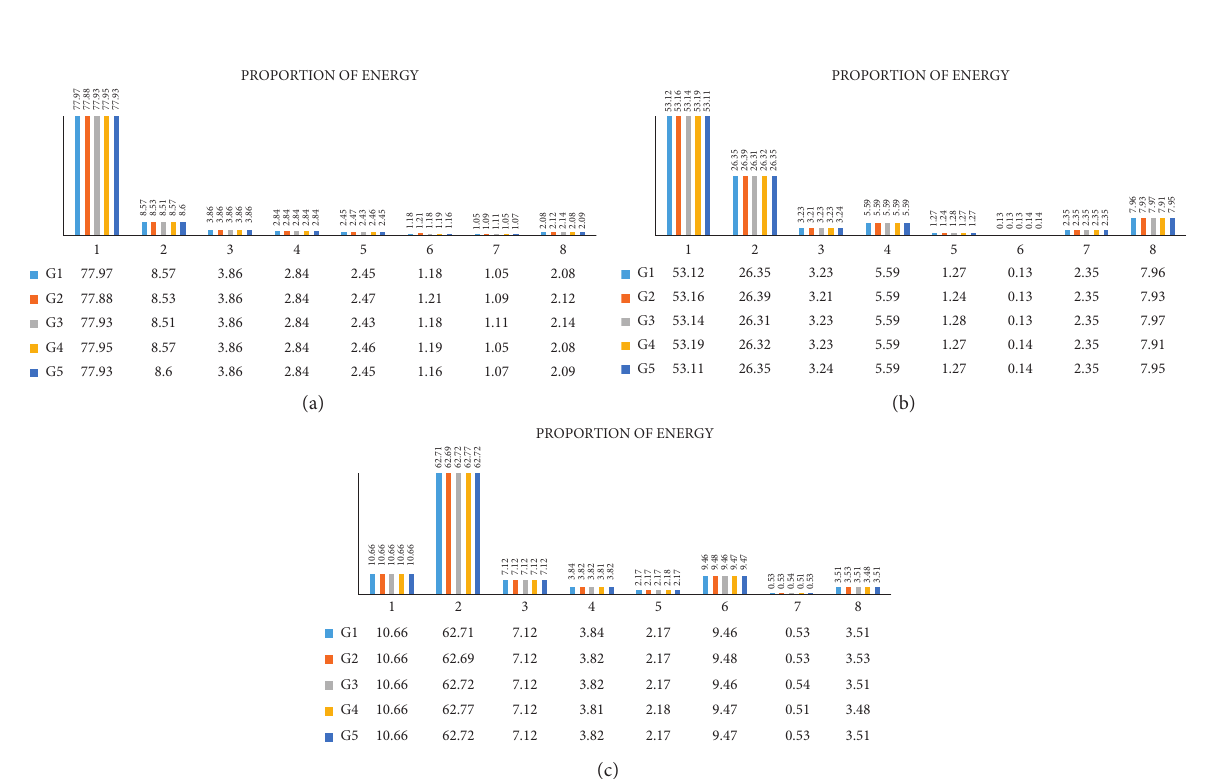
Figure 6: (a) Under fan load condition. (b) Fan bearing fault. (c) Under abnormal condition of fan belt.